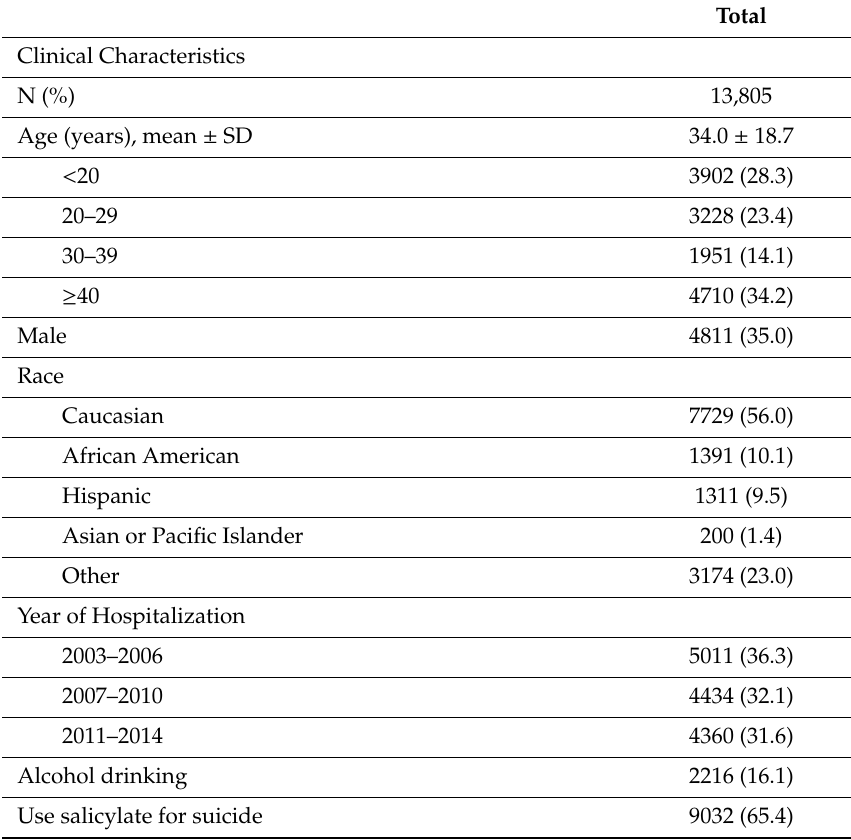
Table 1. Clinical characteristics, in-hospital treatments, complications, outcomes, and resource use for hospitalized patients with salicylate